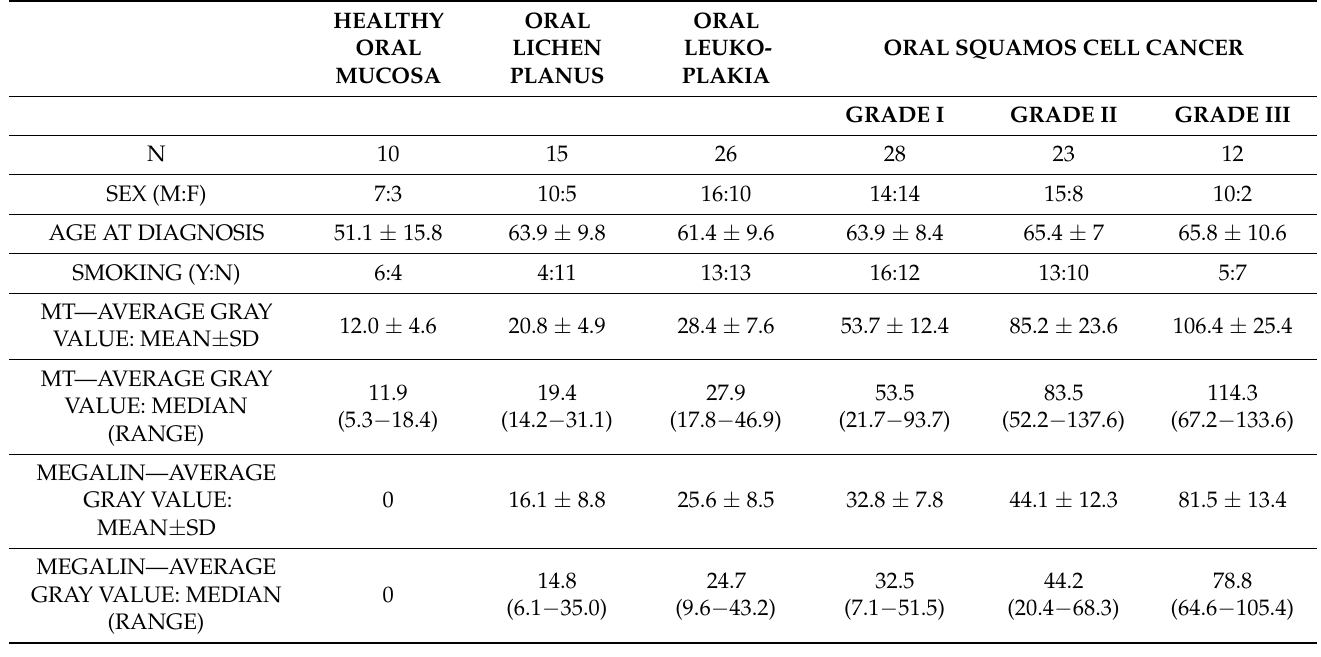
Table 1. Basic demographic and clinicopathological features of involved subjects, and variables measured in the